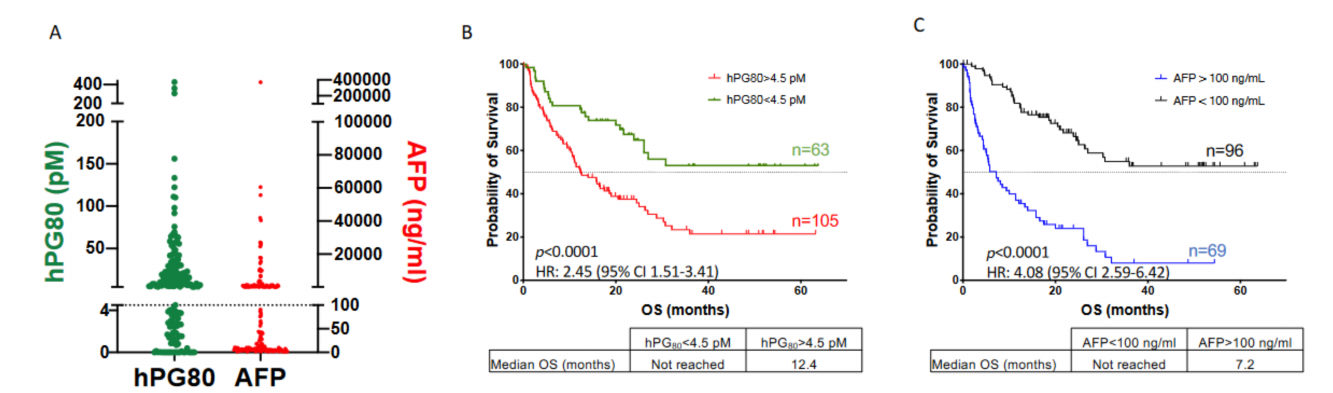
Figure 3. Levels of plasma hPG 80 and overall survival of HCC patients according to hPG 80 or AFP levels. ( A ) Plasma hPG 80 and AFP levels in HCC patients ( n = 168). A cutoff value of 4.5 pM for hPG 80 was set based on the optimal calculated cutoff value. The cutoff value for AFP was set at 100 ng/mL. ( B ) Kaplan-Meier analysis of overall survival (OS) for HCC patients according to hPG 80 levels (cutoff: 4.5 pM; hPG 80 < 4.5 pM: n = 63; hPG 80 > 4.5 pM: n = 105). ( C ) Kaplan-Meier analysis of OS for HCC